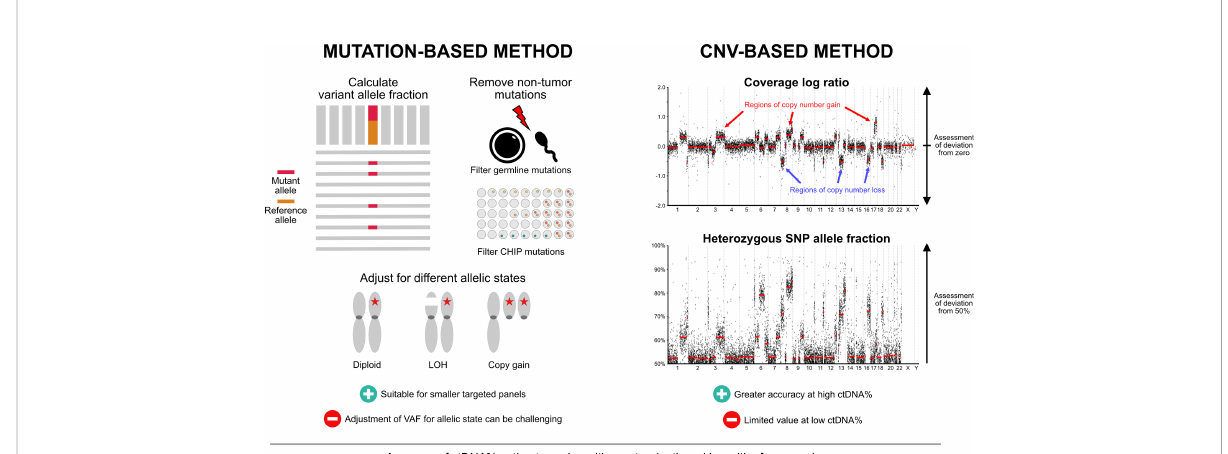
FIGURE 1 Approaches to ctDNA fraction estimation. Both mutation-based and copy number-based approaches are used for ctDNA% estimation. Mutation-based approaches typically utilize the variant allele fraction of truncal mutation(s), with or without adjustment for different allelic con fi gurations. Germline mutations and mutations arising from clonal hematopoiesis of indeterminate potential are removed to prevent contribution to ctDNA% estimates. Mutation-based methods can be complemented by systematic assessments of genomic regions affected by copy number changes. Regions of copy gain or loss are identi fi ed by evaluating sequencing read depth ratios and/or shifts in B-allele frequency at germline heterozygous SNP loci. The degree of signal from segment-level copy number alterations can then be used with overall tumor ploidy estimates to calculate ctDNA%. Panels that provide both mutation and copy number data encompassing broad genomic territory are likely to yield the most accurate estimates across a spectrum of ctDNA%. Abbreviations: CHIP, clonal hematopoiesis of indeterminate potential; ctDNA%, circulating tumor DNA fraction; LOH, loss-of-heterozygosity; SNP, single nucleotide polymorphism; VAF, variant allele